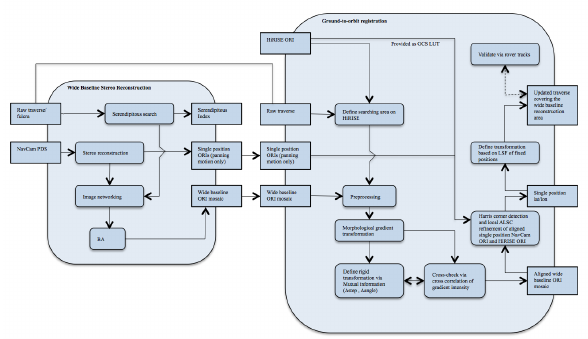
Figure 5. Flow diagram of implemented ground-to-orbit fusion processing